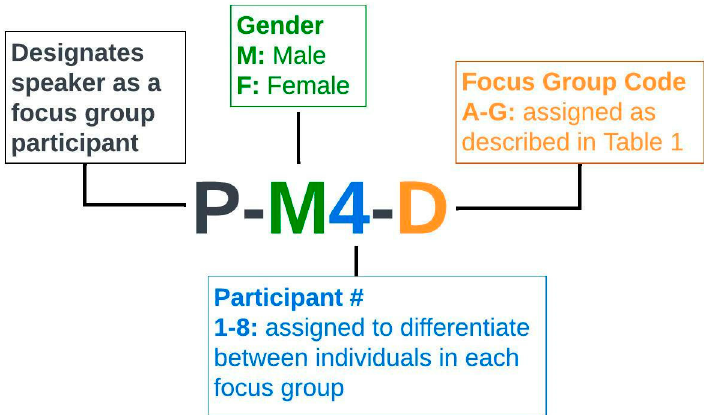
Figure 1. Structure for focus group participant identifier codes in transcripts. # Participant numbers were assigned to differentiate between individuals in each group for the purpose of attributing each transcribed remark to the appropriate individual (e.g., when there are multiple females quoted in a single